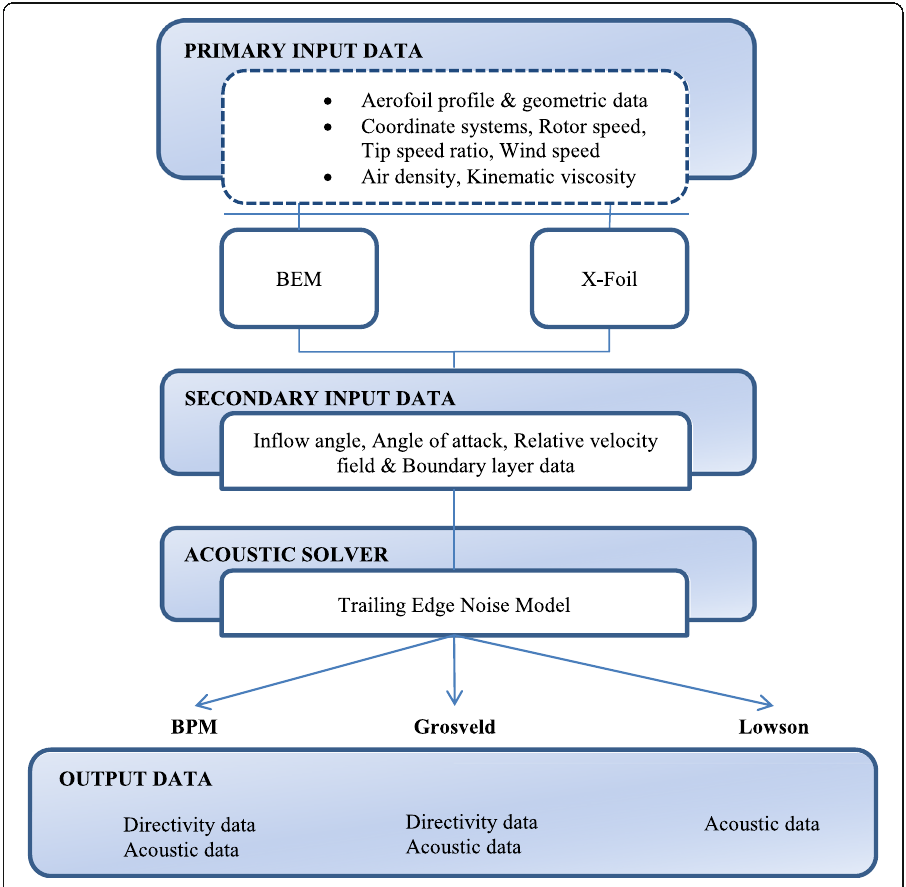
Fig. 1 Block diagram of computational setup of noise prediction